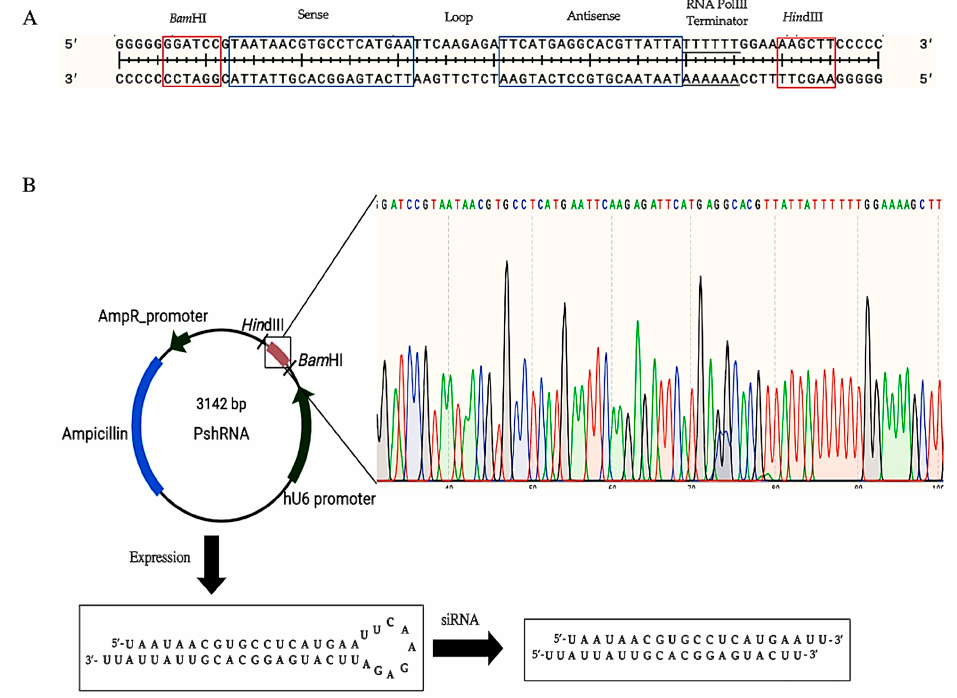
Figure 1. Construction of recombinant plasmid containing Bcl ‐ 2 shRNA sequence. ( A ) Two oligonucleotides containing the sequences of Bcl ‐ 2 siRNA sense, antisense, loop and RNA polymerase III terminator. The oligonucleotides were hybridized, digested with Bam HI and Hin dIII, and ligated to pSilencer 2.0 hU6 vector; ( B ) Recombinant plasmid, PshRNA, carrying Bcl ‐ 2 shRNA sequence. The nucleotide sequence of PshRNA was determined. The electropherogram and nucleotide sequence of the insert are shown. The plasmid expresses Bcl ‐ 2 shRNA, which is converted to siRNA in mammalian cells.